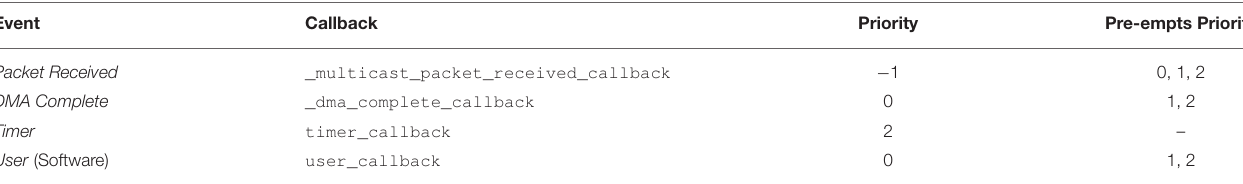
TABLE 1 | Hardware (and single software) events, along with their registered callback and associated priority level. Event Callback Priority Pre-empts